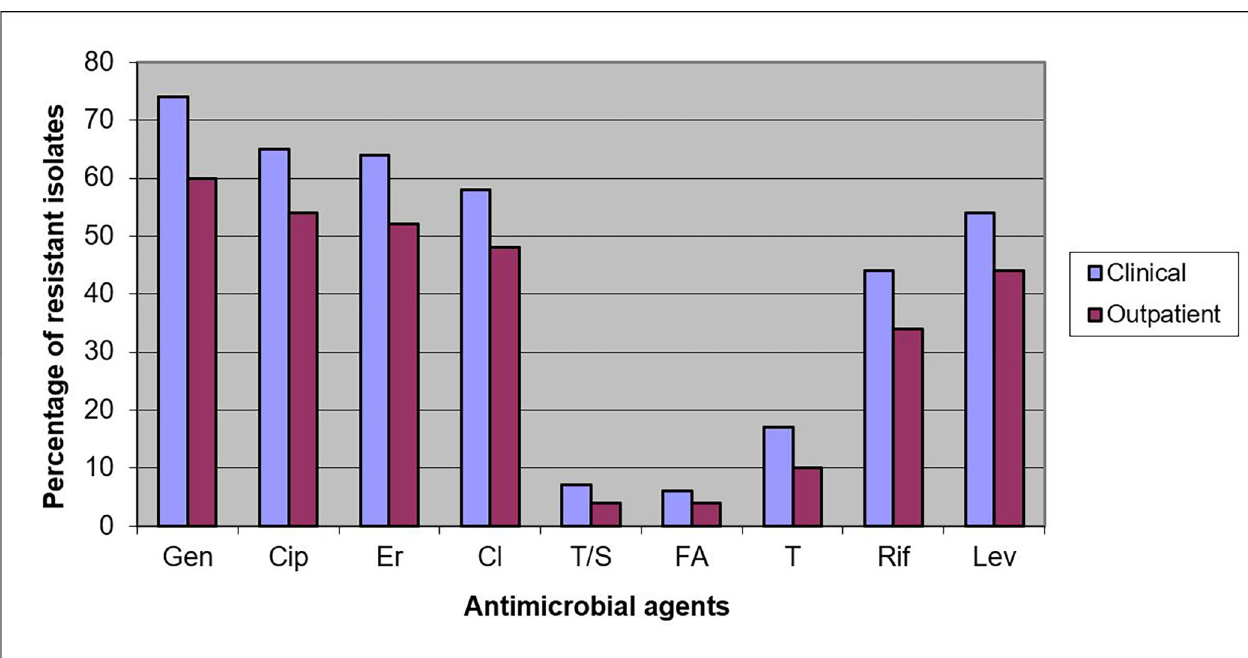
Fig 1. Antimicrobial resistance in clinical and outpatient MRSA isolates. Gen-gentamicin; Cip-ciprofloxacin; Er- erythromycin; Cl—clindamycin; T/S trimethoprim/sulfamethoxazole; FA -fusidic acid; T—tetracycline; Rif—rifampicin; Lev- levofloxacin.